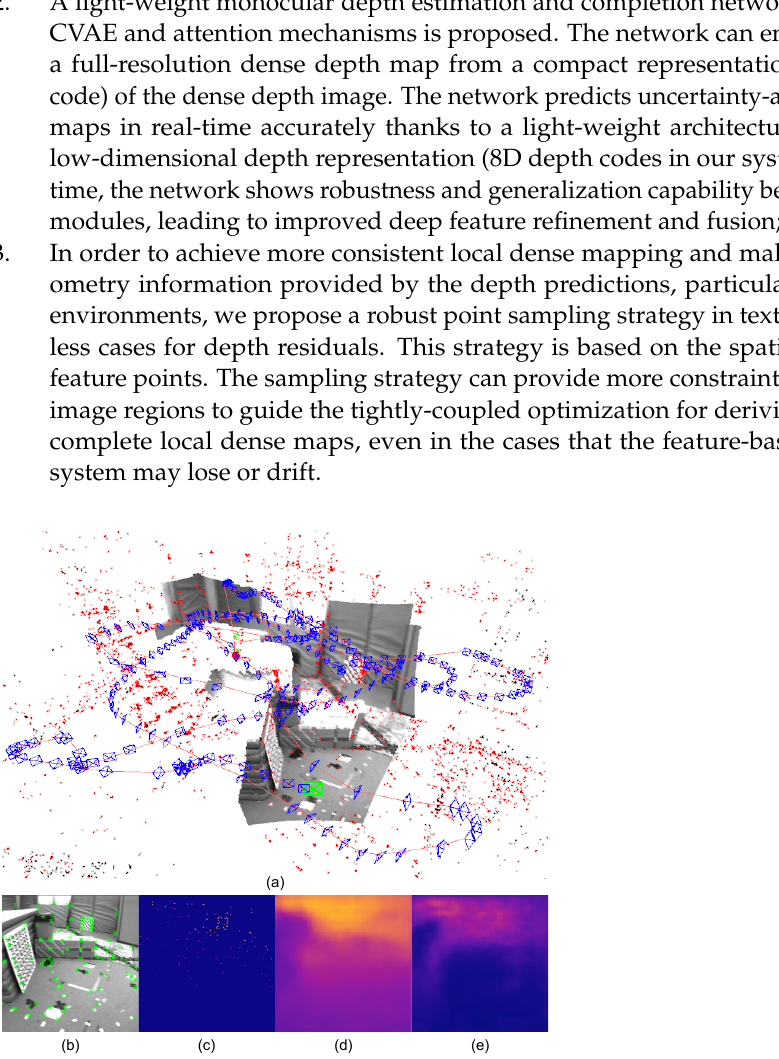
Figure 1. A system demonstration for real-time tracking and local dense mapping on the unseen cross-domain EuRoC dataset of the proposed monocular VI SLAM system. ( a ) Real-time tracking, 3D sparse mapping, and 3D local dense mapping demonstration; ( b ) 2D feature extraction and matching on the gray monocular image; ( c ) the projected sparse depth image; ( d ) the dense depth map predicted by the proposed network only trained on the NYU Depth V2 dataset [20] (warm colors are farther to the camera); ( e ) the depth uncertainty prediction result (warm colors are larger